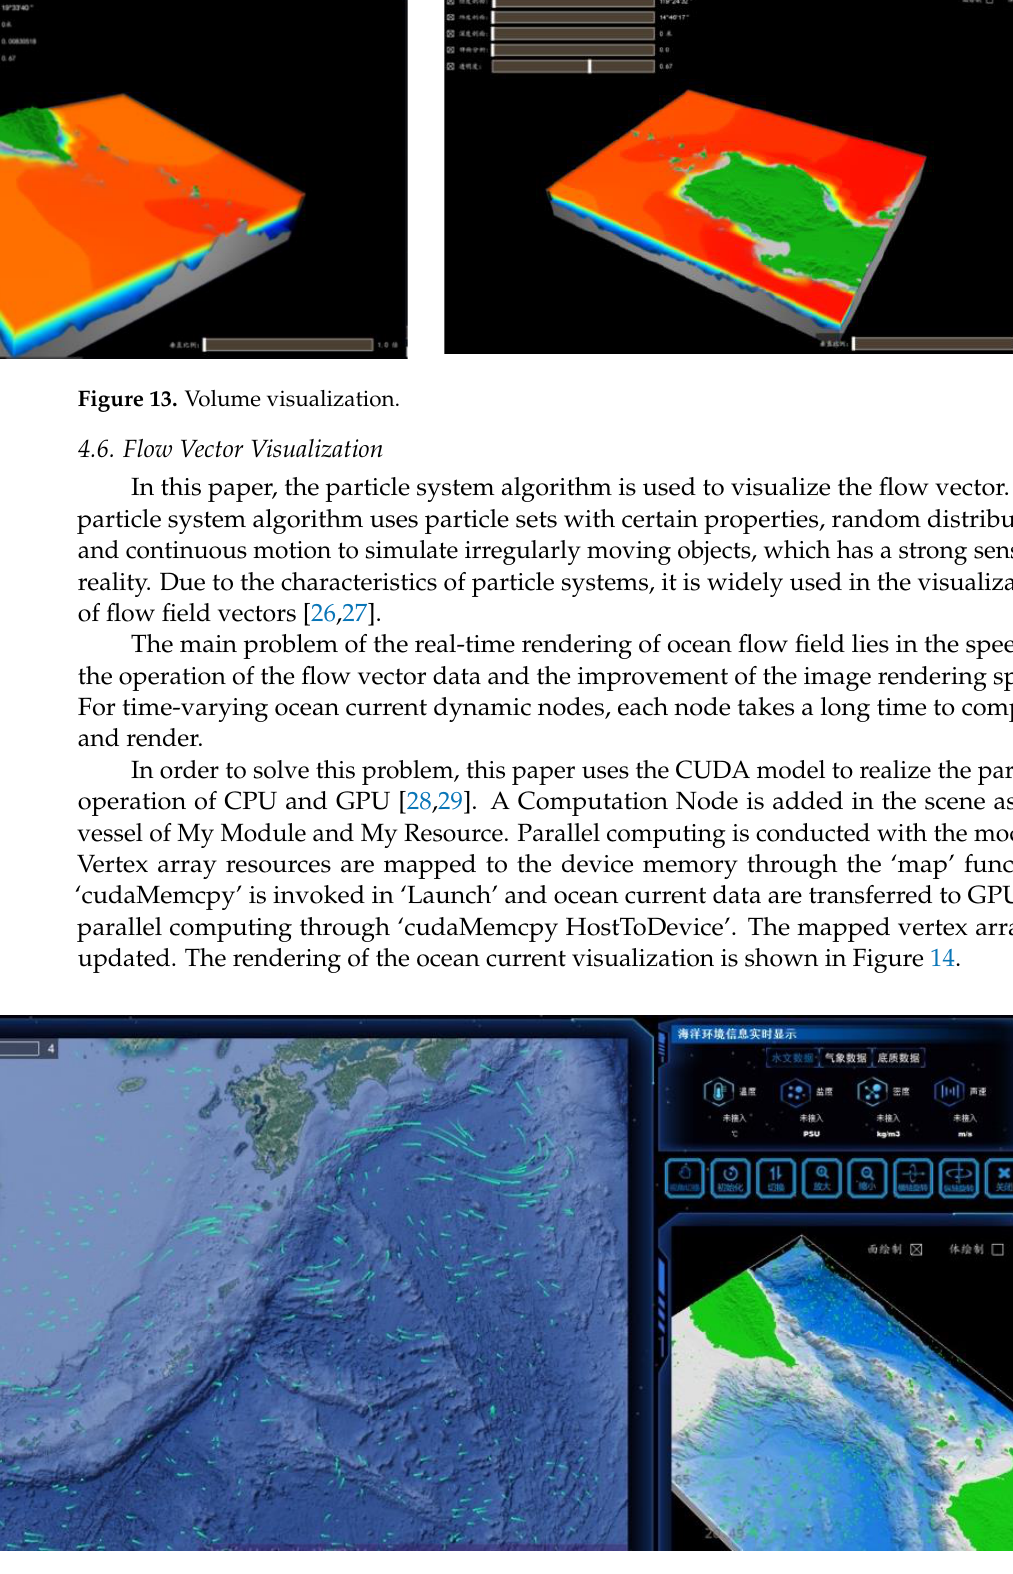
Figure 14. Ocean current visualization.